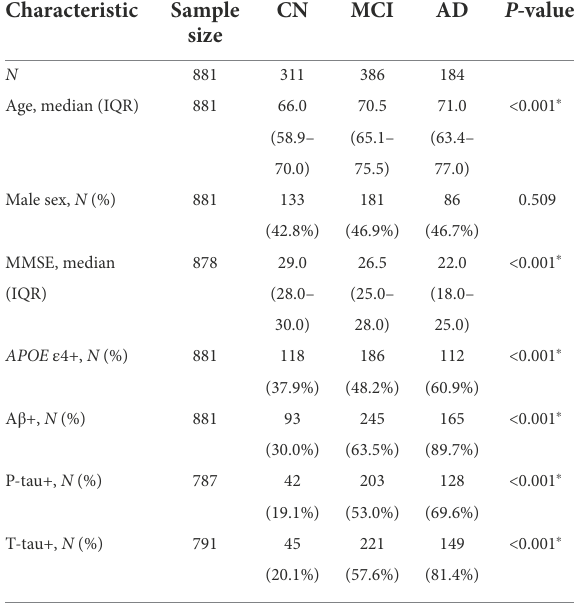
TABLE 1 Demographic and clinical characteristics of the study population.